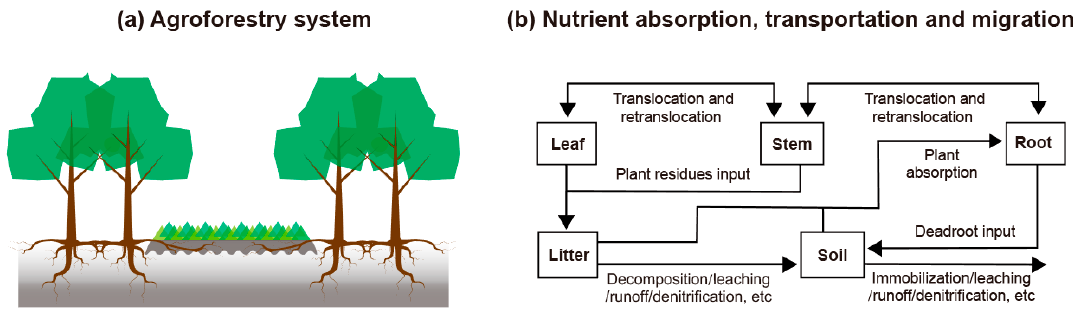
Figure 1. ( a ) Schematic diagram of an agroforestry system; ( b ) the common nutrient cycling processes in an agroforestry system.